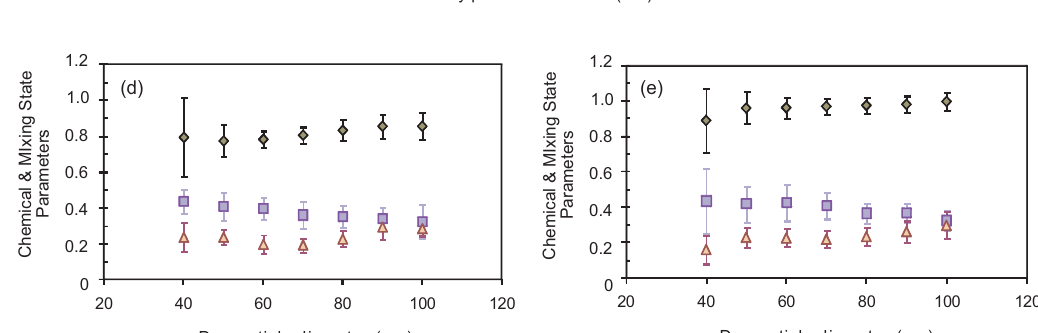
Fig. 8. (a) Time series of the characteristic (SMCA, 100nm diameter) and filter-derived hygroscopicity parameter for the totality of the measurement period, (b) sulfate volume fraction time series and (c) chemical and mixing state parameters ( E ∗ , κ ∗ , σ κ ) averages for the whole measurement period and for 14 July (d) and 24 July (e)